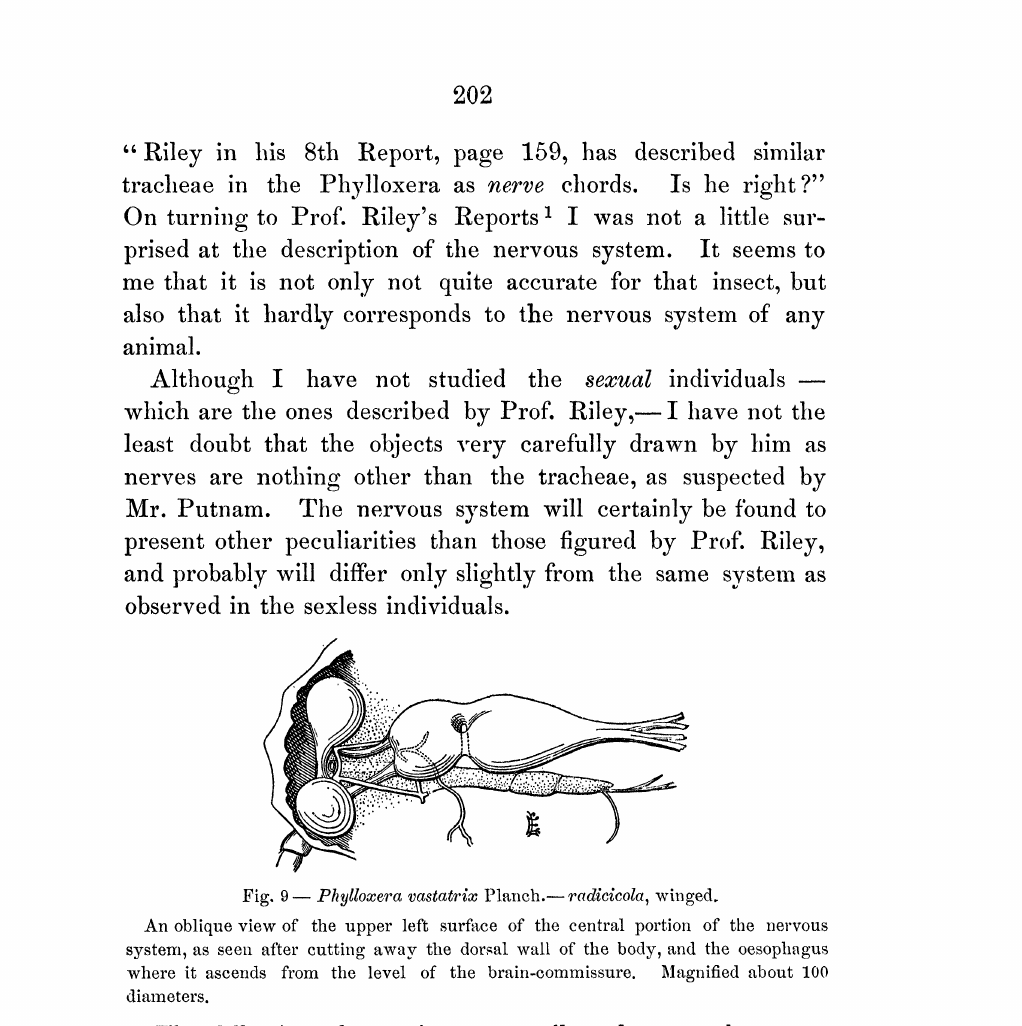
Fig. 9- Phylloxera vastarix Planch.--radicicol, winged. An oblique view of the upper left surfce of the central portion of the nervous system, as seen after cutting away the dorsal wall of the body, and the oesophagus where it ascends from the level of the brain-commissure. Magnified about 100